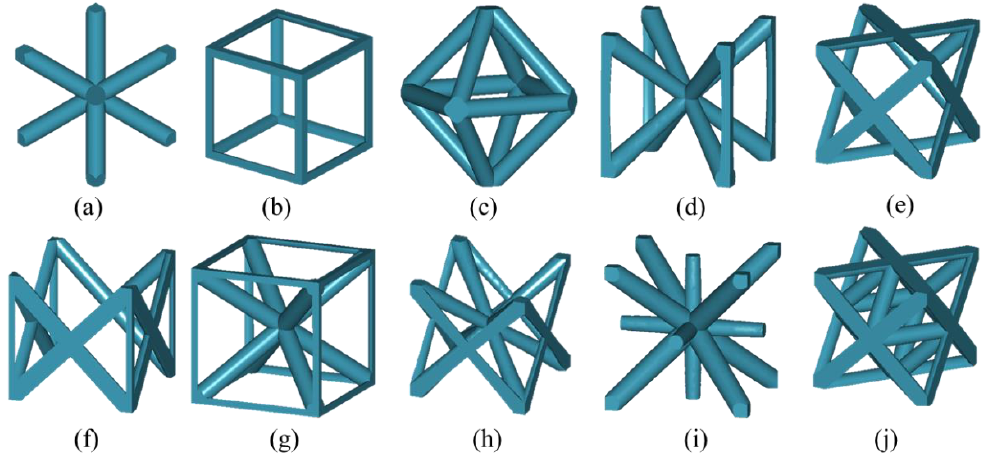
Figure 13. The unit cells of different shapes. ( a ) Body-centered cubic (BCC); ( b ) Simple cubic (SC); ( c ) Octahedron (OCT); ( d ) The BCC with vertical struts (BCCz); ( e ) Face-centered cubic (FCC); ( f ) The FCC with vertical struts and no struts in the horizontal plane (S-FCCz); ( g ) The union of BCC and SC (BCCzxy); ( h ) The union of S-FCC and BCC (S-FBCC); ( i ) Reinforced body-centered cubic (RBCC); ( j ) Octet-truss (OT).